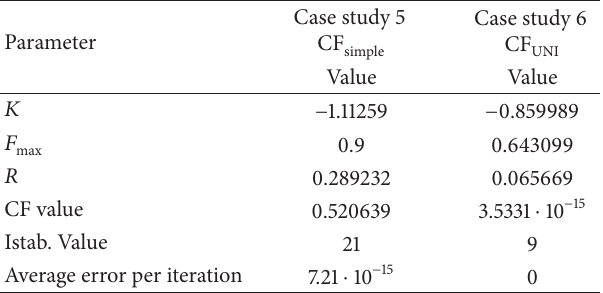
Table 9: Characteristics of the best solution: joined case studies 5 and 6, Lozi map as CPRNG/controlled